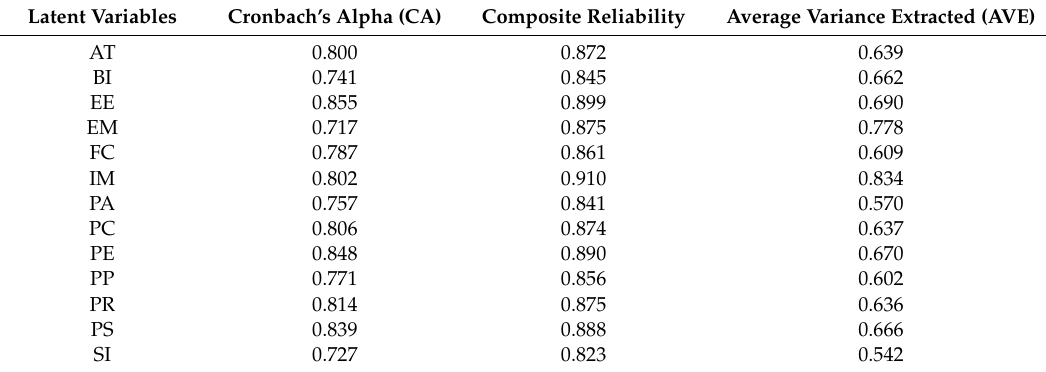
Table 3. Construct reliability and validity.